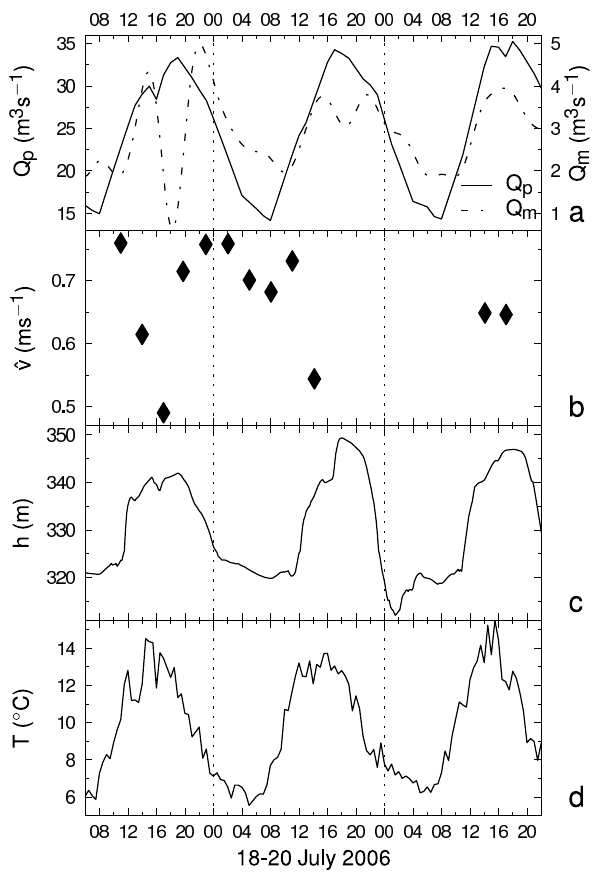
Fig. 4. Tracer and other hydraulic measurements: (a) proglacial dis- charge (solid line, left scale) and inferred discharge into the moulin (dashed line, right scale, cf. Eq. 1), (b) tracer transit speed, (c) water pressure head in borehole, (d) air temperature. The vertical dotted lines demarcate the